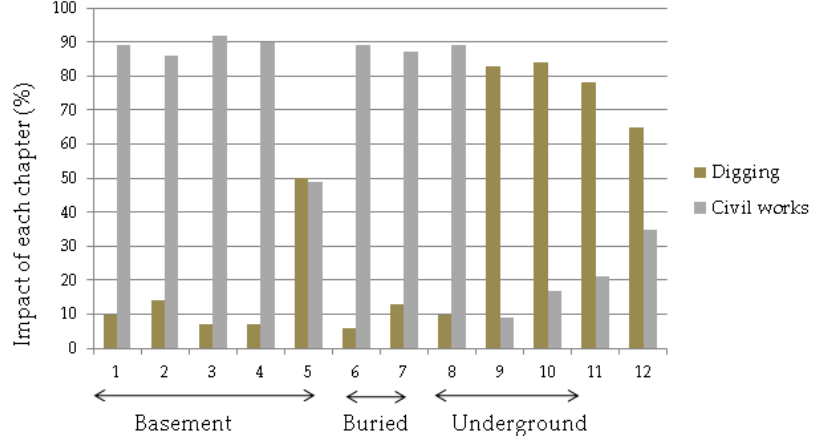
Figure 10. Construction costs by chapter associated with each of the analyzed warehouses.